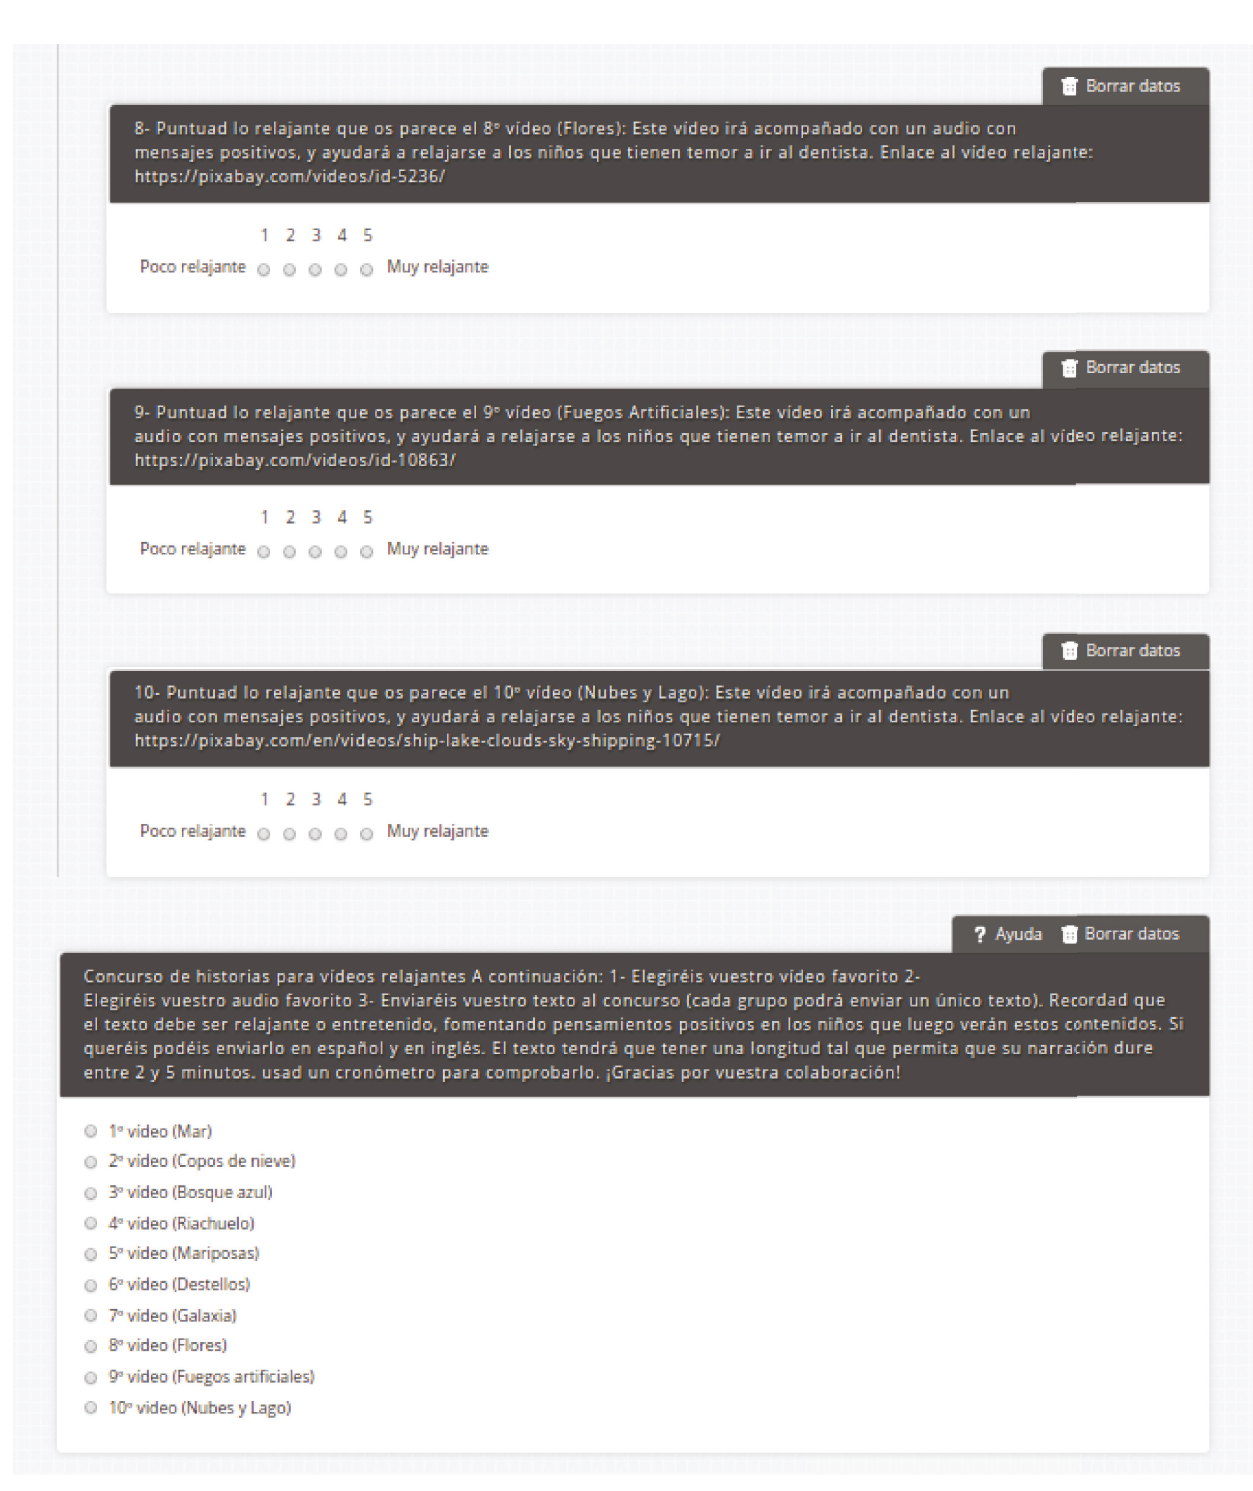
Figure 24: Online survey manager questionnaire to select multimedia resources in the second intervention (primary